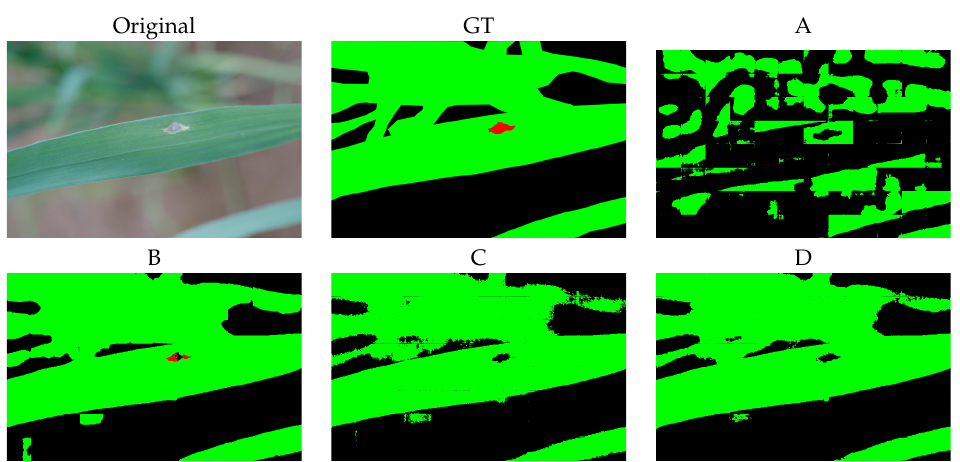
Figure 24. Compared results of semantic segmentation for Rice blast experiments.